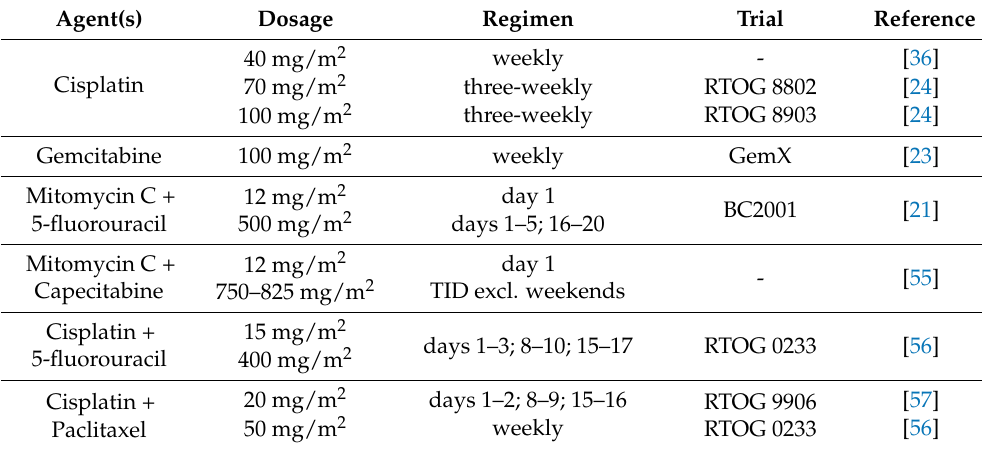
Table 1. Cytotoxic agents commonly used for